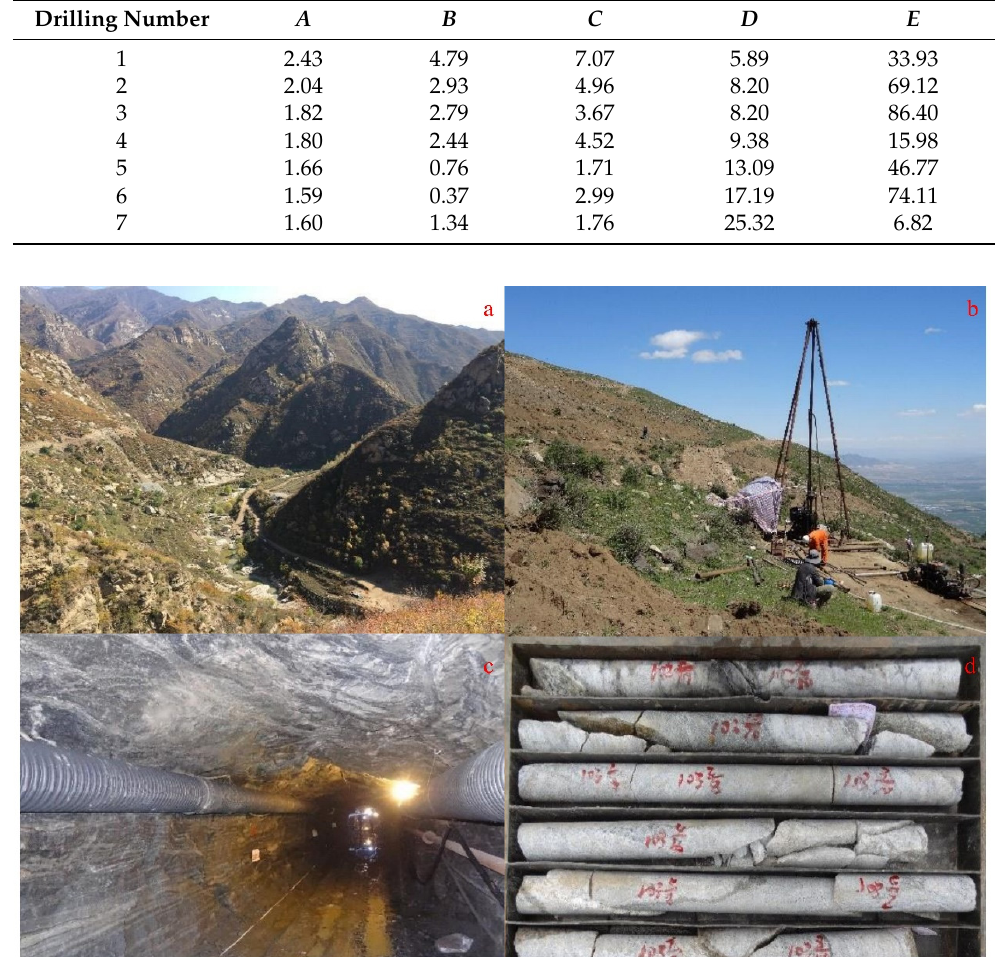
Table 2. High-pressure pipeline section analysis data.